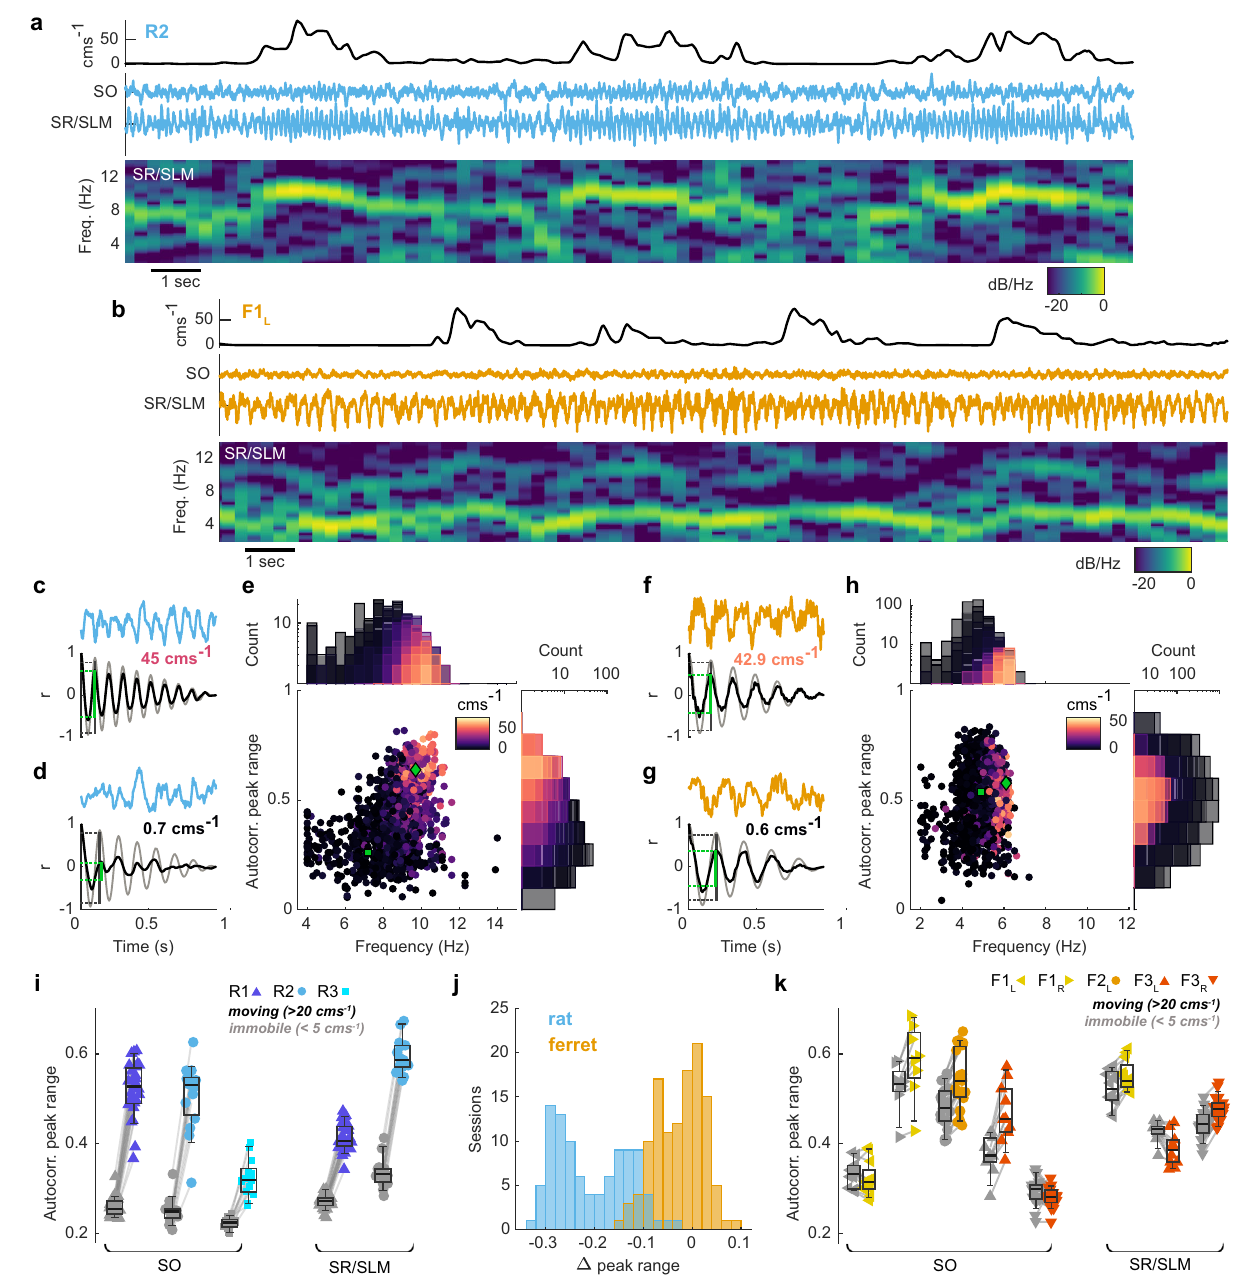
Fig. 4 | Low frequency oscillatory activity persists during immobility in the ferret hippocampal LFP. 20s of example data from one rat ( a R2) and one ferret ( b F1 L ). Top: Head speed showing multiple periods of immobility and movement. Middle: LFP traces from stratum oriens (SO) and stratum radiatum/stratum lacu- nosum moleculare (SR/SLM) corresponding to the speed trace above. Bottom: Spectrogram of SR/SLM LFP above, normalised to maximum power. Example data segments illustrating the autocorrelation-based method of quantifying oscillatory activityfrom LFP recordedduring locomotion ( c )and immobility( d )inR2SR/SLM (top: blue line) and corresponding autocorrelation (bottom: black). The matched sinusoid wave autocorrelation (grey) is used for frequency estimation and peak range estimation. Green line indicates the uncorrected peak range measurement for this example, vertical grey line indicates peak range of matched sinusoid used for normalisation. Text shows mean speed in example epochs. e Scatter plot and marginal histograms showing estimated frequency and peak range for all epochs from one session recorded in rat R2. Each marker represents one epoch and is